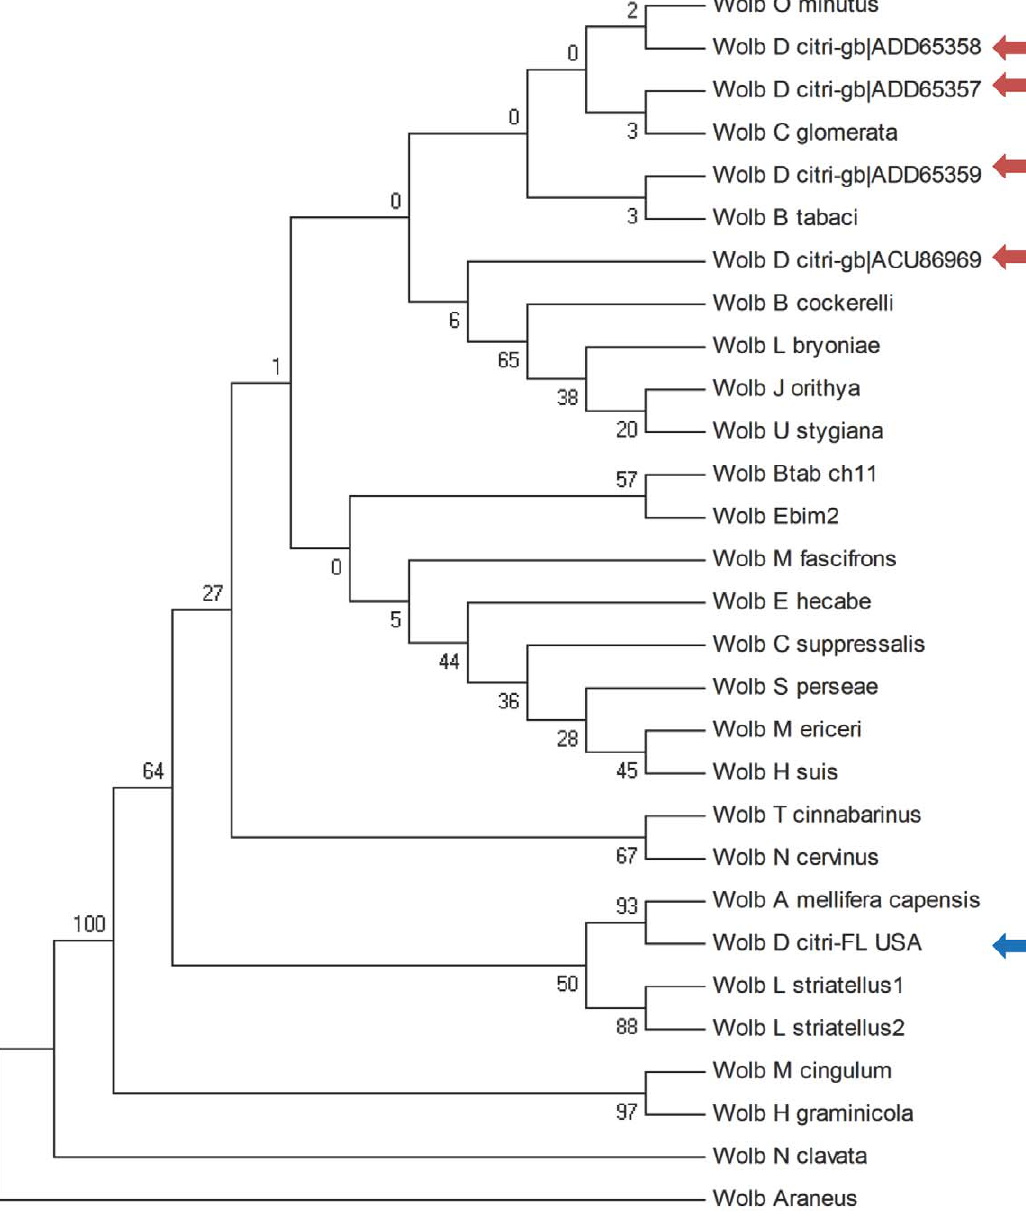
Figure 4. Maximum Parsimony tree for Wolbachia Wsp sequences highlighting the placement of Florida (blue arrow) and Chinese isolates (red arrows) in different sub-clades of supergroup B.